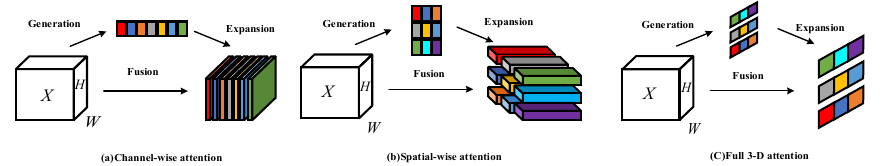
Figure 14. Comparison of the implementation process of different attention mechanisms.